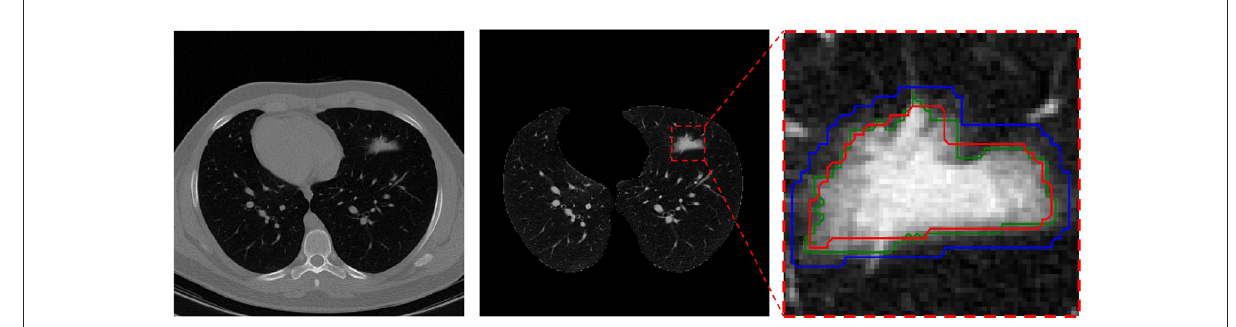
FIGURE1 Mask pre-processing in the infection segmentation dataset. Left is the raw CT scan slice, middle is the lung image in the same slice (with infection in the upper-left lobe), and right is the segmented infection area in the image. In the right, the red contour depicts the radiologist manual mask edge, the blue contour is the dilated red contour, and the green contour s the rectified mask edge.